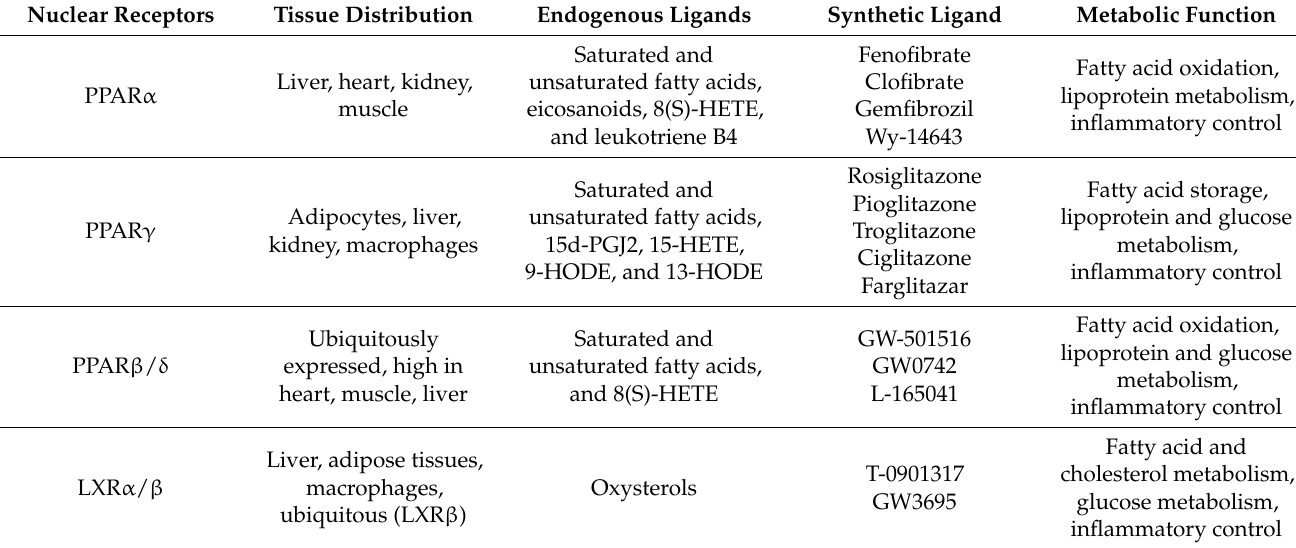
Table 1. Modulatory role of PPAR and LXR in metabolic